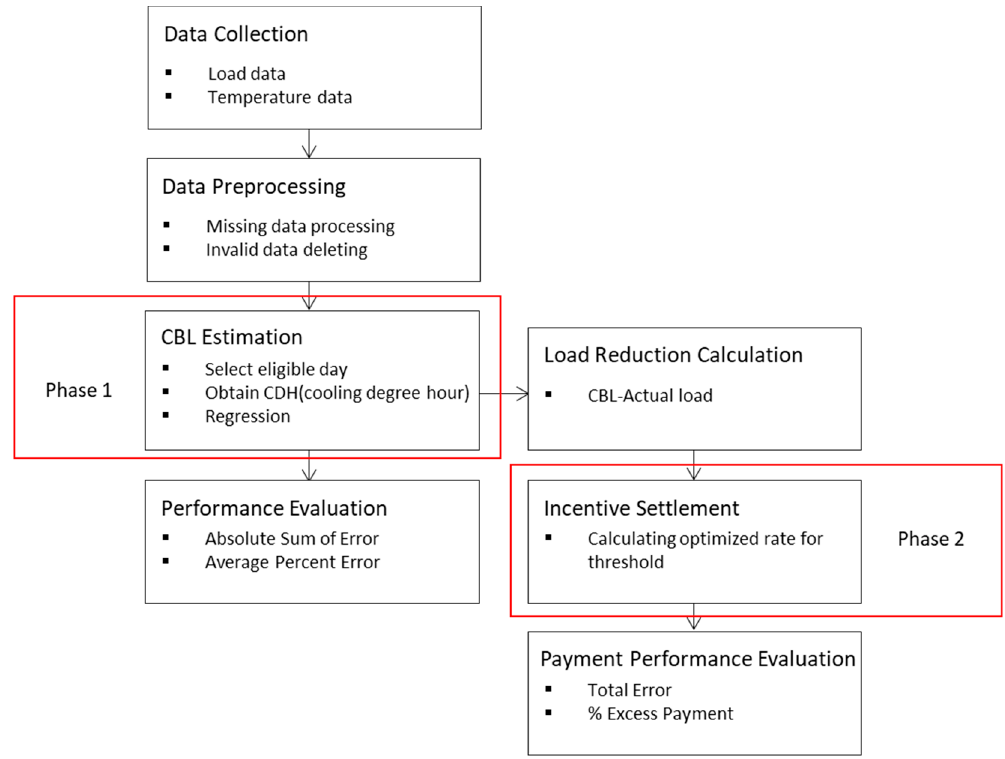
Figure 1. Flowchart of the proposed customer baseline load (CBL) estimation and incentive settlement method and corresponding evaluation processes.